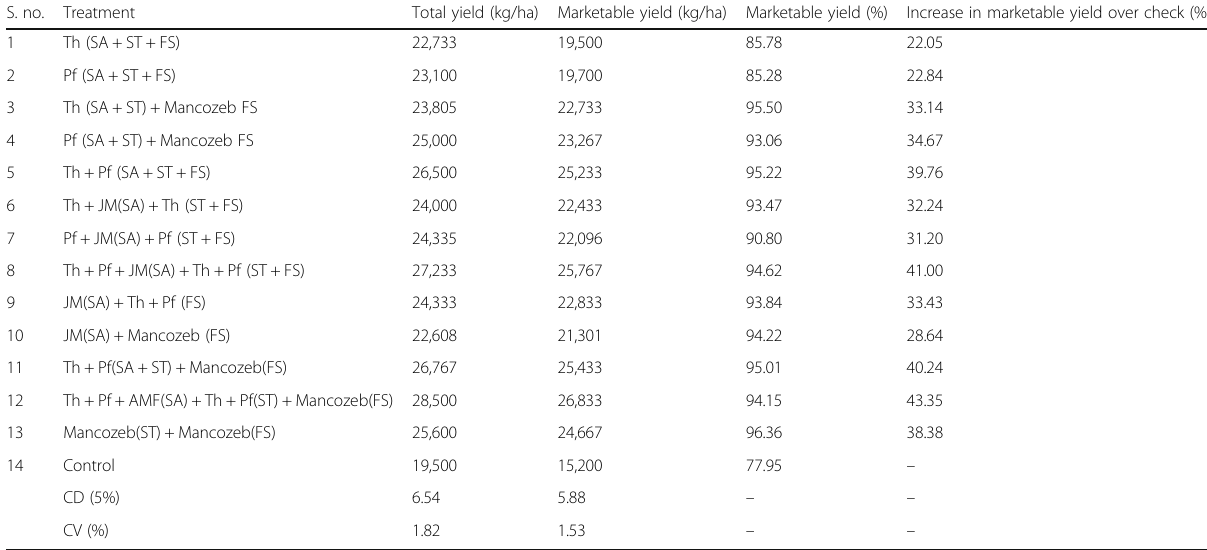
Table 4 Effect of biocontrol agents, arbuscular mycorrhizal fungi, and fungicide alone and in combinations on the yield of tomato in the field at Vegetable Research Centre during 2014 –